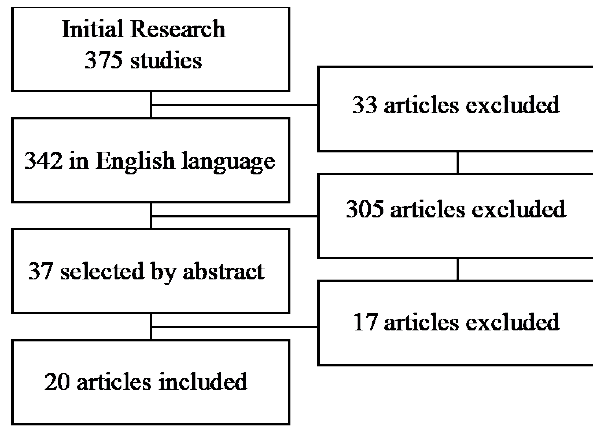
Graph 1. Literature search flow